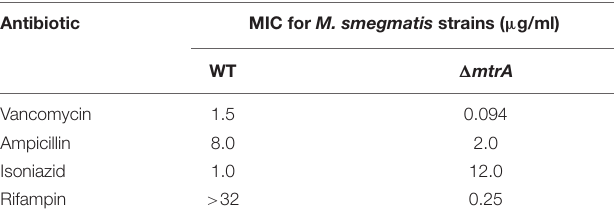
TABLE 1 | Antibiotic resistance profile of (cid:49) mtrA in comparison to the wild type M. smegmatis . Antibiotic MIC for M. smegmatis strains ( µ g/ml) WT (cid:49)